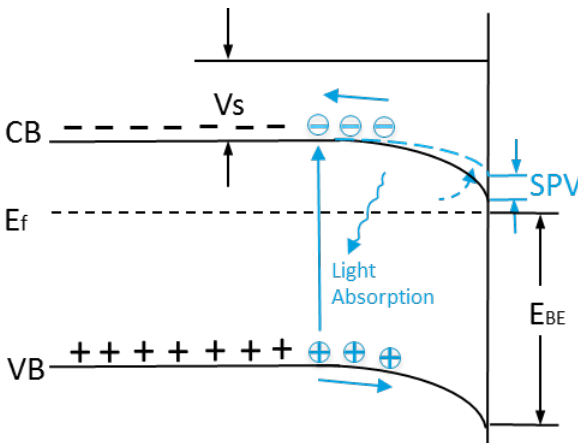
Figure 4. Schematic of the downward band bending on n-Si treated by BQ and the SPV measurement. Carriers depicted in blue are generated upon absorption of light. CB: the bottom of conduction band; E f : the Fermi energy level; VB: the top of valence band; V s : the surface potential barrier.